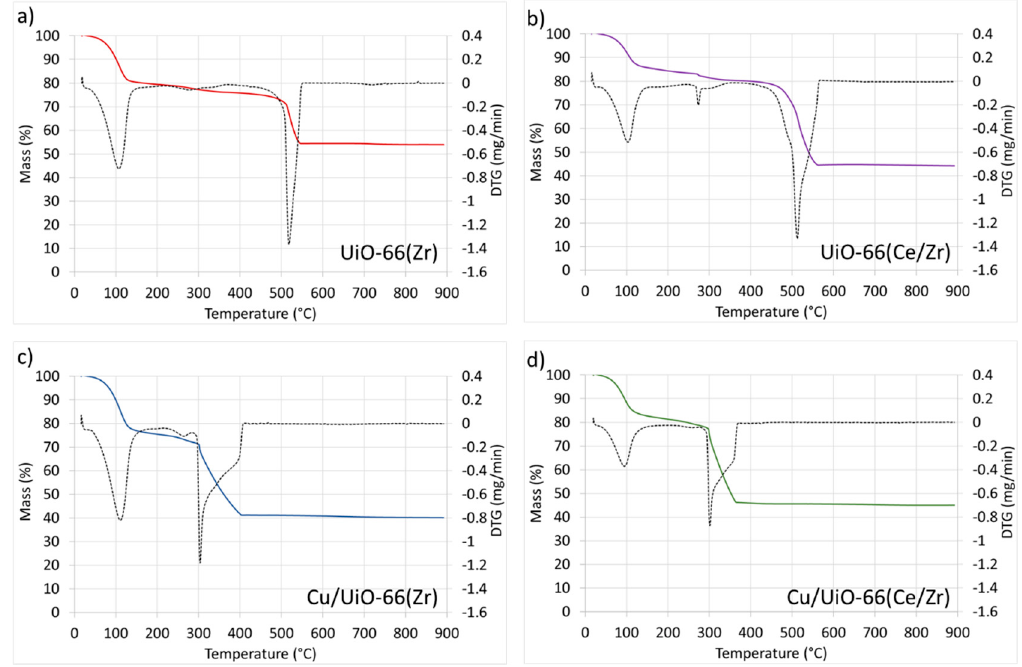
Figure 8. TG (—) and DTG ( ... ) for UiO-66 and Cu / UiO-66 materials, a ) UiO-66(Zr), b ) UiO-66(Ce / Zr), c ) Cu / UiO-66(Zr), d ) Cu / UiO-66(Ce / Zr).